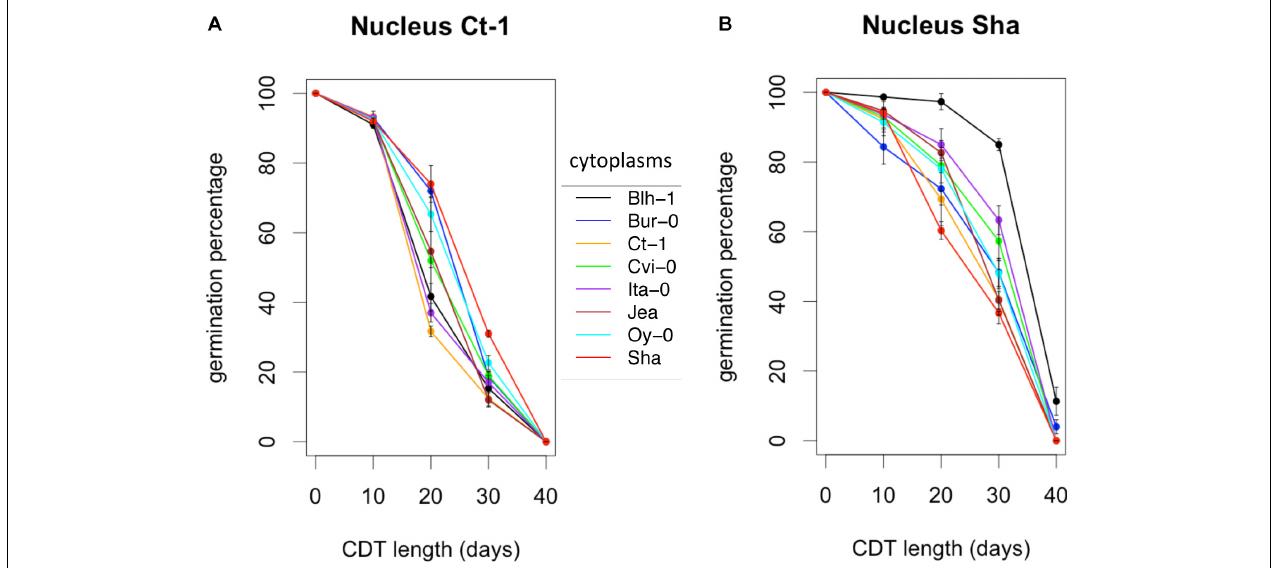
FIGURE 4 | Kinetics of loss of germination efficiency during artificial aging. Controlled deterioration treatment (35 ◦ C, 75% RH) was applied for different durations to seeds from cytolines of the Ct-1 (A) and Sha (B) nuclear series. The means of maximum germination percentage from three replicates were plotted. Vertical bars indicate standard deviations from the mean. The colors of the graphs indicate the cytoplasms of the genotypes: black, Blh-1; blue, Bur-0; orange, Ct-1; green, Cvi-0; purple, Ita-0; brown, Jea; cyan, Oy-0; red, Sha.